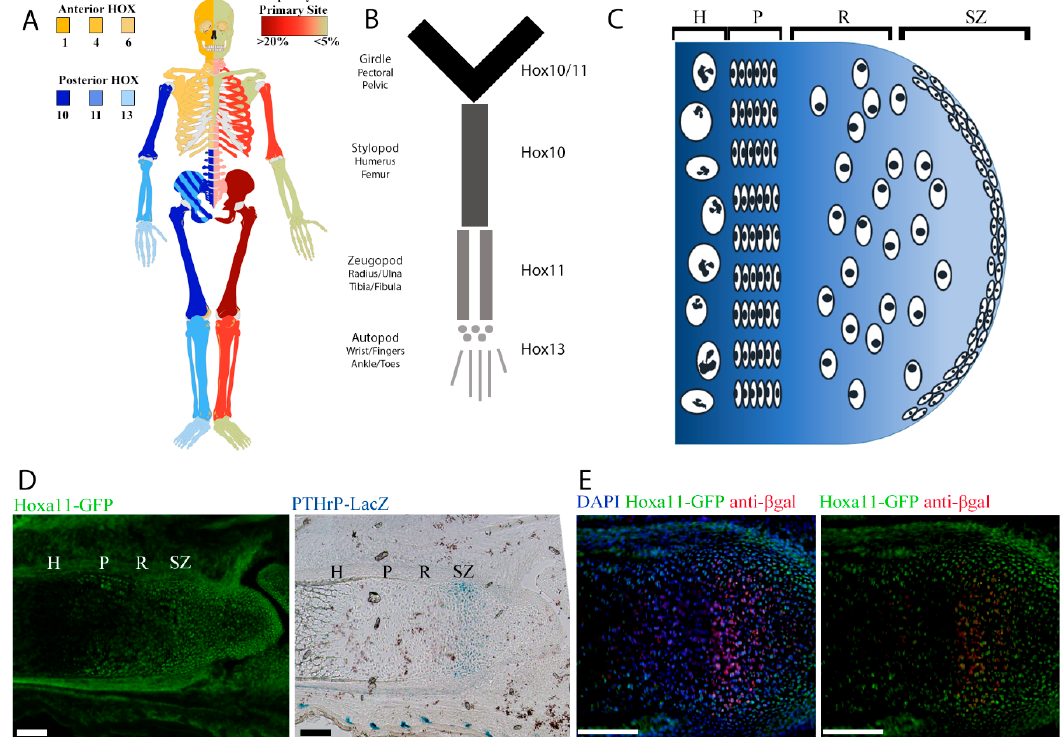
Figure 1. Human Ewing sarcoma localizes to skeletal compartments where posterior HOX genes are expressed. ( A ) Human skeleton demonstrating anterior (yellow) and posterior (blue) expression of HOX genes on the left contrasted with frequency of Ewing sarcoma primary site (red) on the right. ( B ) Anatomic terms for skeletal regions of the limbs. ( C ) Cartoon demonstrating the location of the embryonic superficial zone (eSZ) on the ends of the bones that undergo endochondral ossification. The eSZ lies above the growth plate: resting zone (R), proliferative zone (P), hypertrophic zone (H). ( D ) Micrographs of E18.5 zeugopod, Hoxa11-EGFP (green fluorescent protein) in green, Pthrp-Lacz in blue in an adjacent section. Scale bars represent 100 µm. ( E ) Micrographs of E18.5 zeugopod, Hoxa11-GFP in green, anti- β gal in red. Scale bars represent 100 µm.